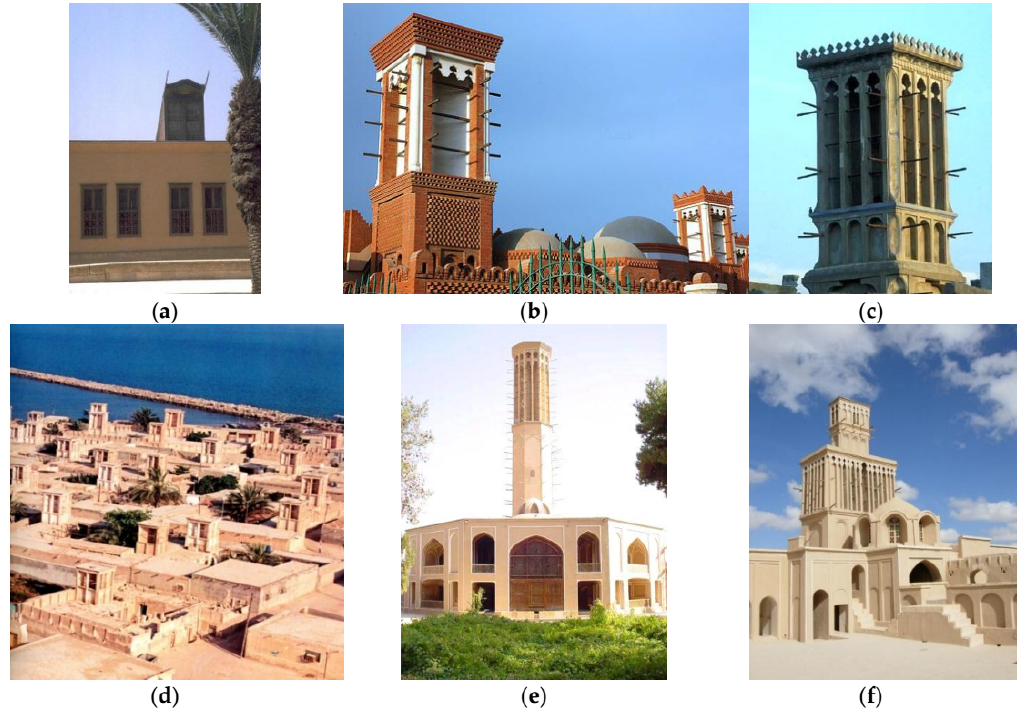
Figure 3. View of the wind towers in ( a ) Cairo, Egypt, ( b ) Duha, Qatar, ( c ) Dubai, UAE, as well as ( d ) Bandar Lengeh, ( e ) Yazd and ( f ) Abarkouh in Iran